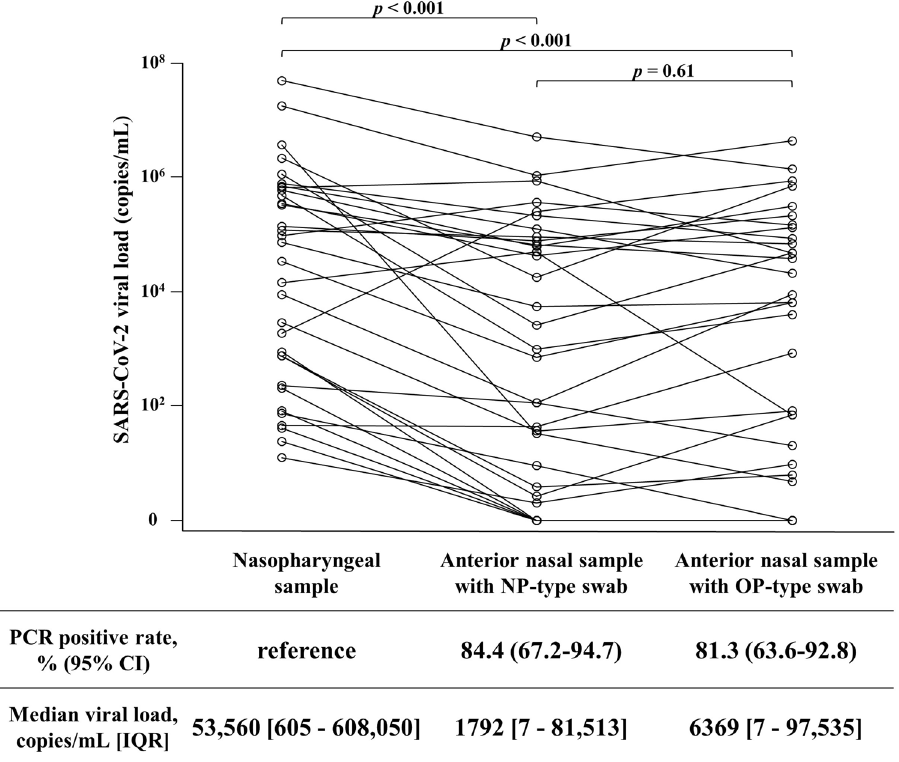
Figure 1. Comparison of SARS-CoV-2 viral loads between each collection site and swab type. The set of viral loads in the same participant is represented by connected lines. The viral loads were compared by the Wilcoxon signed-rank test, and p values are corrected with Holm correction. NP-type swab nasopharyngeal-type swab, OP-type swab oropharyngeal-type swab, CI confidence interval, IQR interquartile